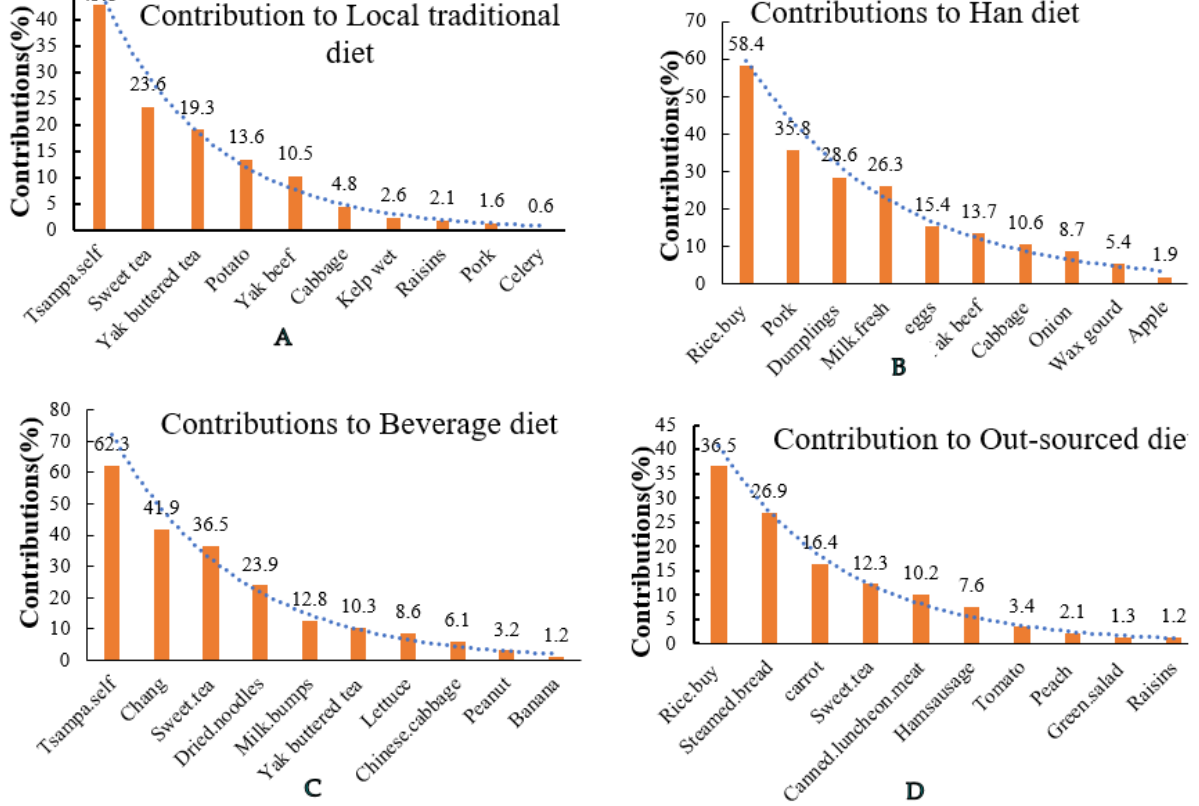
Figure 6. The 10 highest contributing food groups to each dietary pattern. P.S. Tsampa.self: home-grown tsampa; Rice.buy: rice purchased at the market. ( A ). The 10 highest contribution food groups to Local traditional diet. ( B ). The 10 highest contribution food groups to Han diet. ( C ). The 10 highest contribution food groups to Beverage diet. ( D ). The 10 highest contribution food groups to Out-sourced diet.